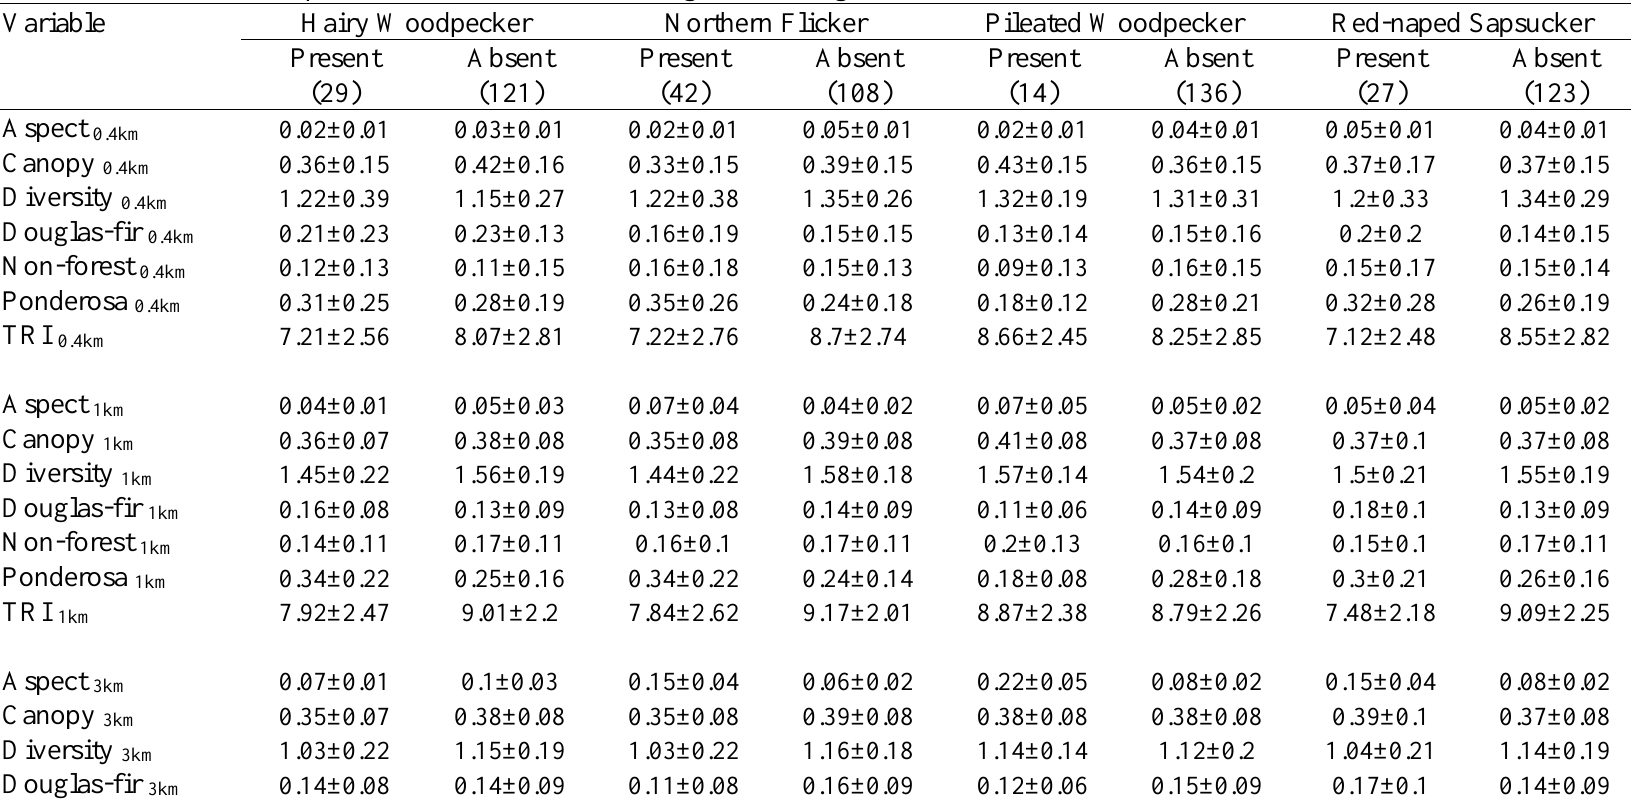
Table A1.3. Landcover and topographic variables ( 𝑥 ̅ ± SE) within 0.4-, 1- and 3-km radius circular plots surrounding point-count locations where woodpeckers were present versus absent in the Boise National Forest, Idaho, USA during 2009-2010. Proportion of canopy cover, Douglas-fir, non-forest, and ponderosa as well as landcover diversity, which was calculated as the Shannon Diversity Index, were derived from the LANDFIRE (2013) dataset. The topographic variable aspect was transformed using a cosine transformation and TRI (terrain ruggedness index) was expressed as the average elevational difference between adjacent cells in a digital elevation model (The National Map 2013). Snag characteristics were only measured at the 0.4 km-scale using 10m-wide belt transects centered on the point-count location and totaling 1km in